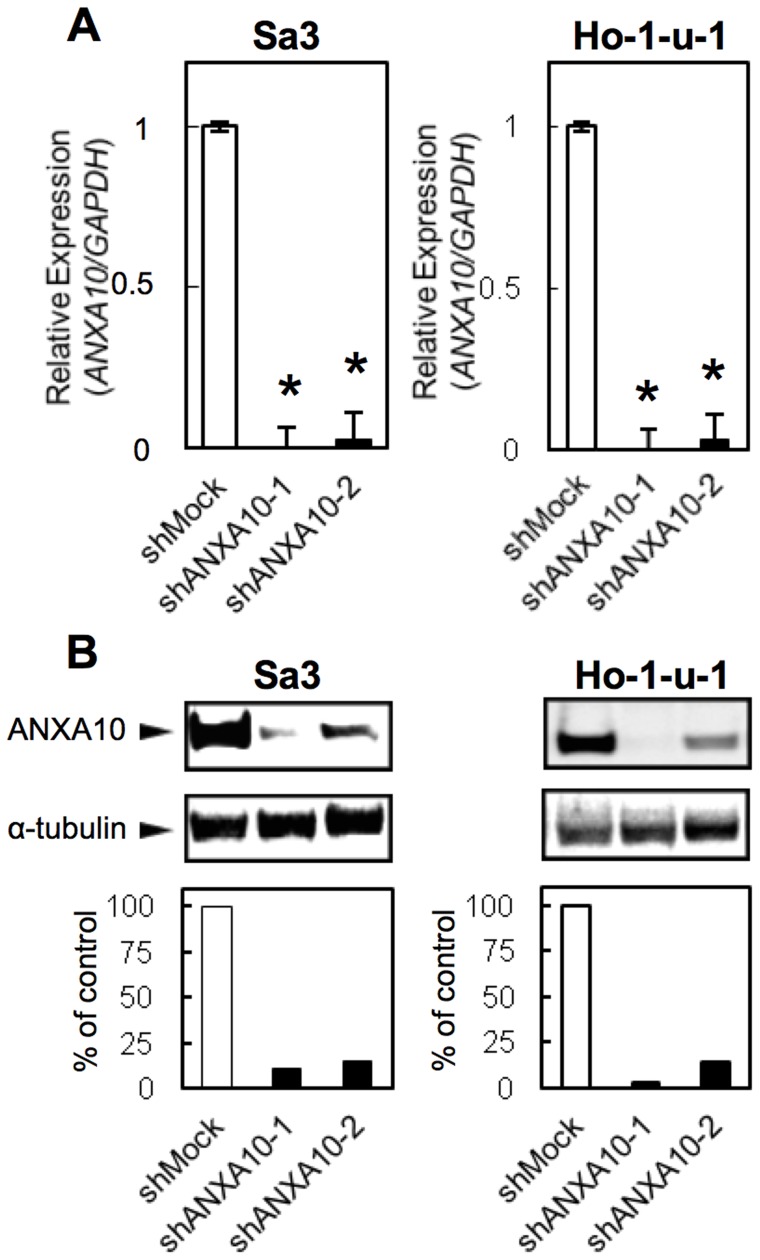
Expression of ANXA10 in shANXA10-transfected cells.(A) qRT-PCR shows that ANXA10 mRNA expression in the shANXA10-transfected cells (Sa3- and Ho-1-u-1-derived transfectants; 2 clones each) are significantly lower than in the shMock-transfected cells (*p<0.05; Mann-Whitney U test). (B) Immunoblotting analysis shows that the ANXA10 protein levels in shANXA10-transfected cells (Sa3- and Ho-1-u-1-derived transfectants; 2 clones each) also have decreased markedly compared with that in the shMock-transfected cells.